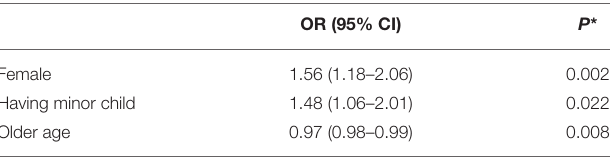
TABLE 4 | Multivariable models showing association between baseline risk factors and depressive